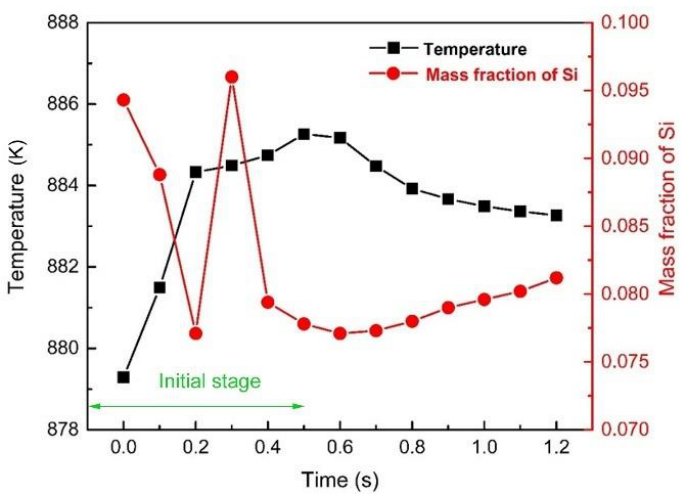
Figure 8. Variations in temperature and Si concentration at the center region of the mixture due to standing time.